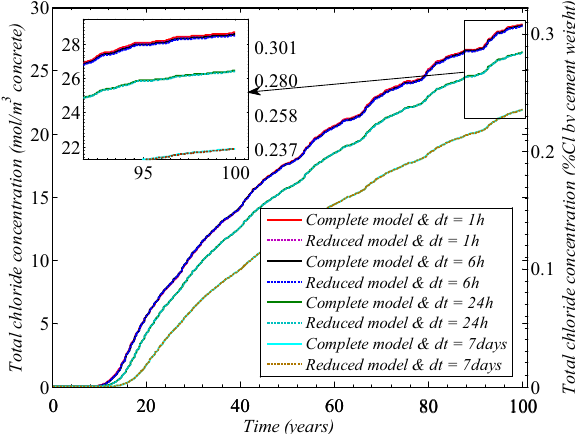
Fig. 10 Comparison of models considering various time- steps for a RC subjected to salt spray in Nice, France.